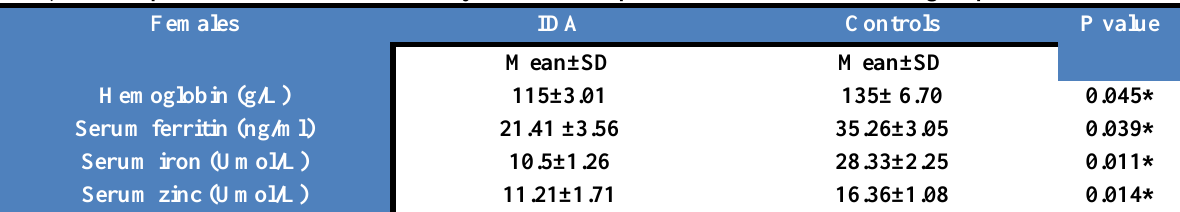
Table, 4: Some parameters for iron deficiency anemia with parasitic worms and control groups in females Females IDA Controls Hemoglobin (g/L)